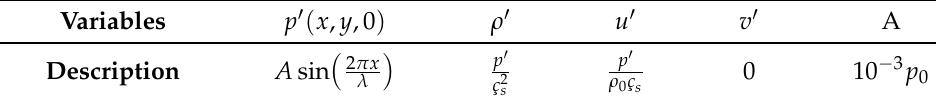
Table 1. Parameters for the planar standing wave.